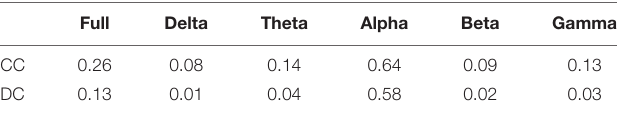
TABLE 1 | Quantification of the spectral specificity of the hemodynamic